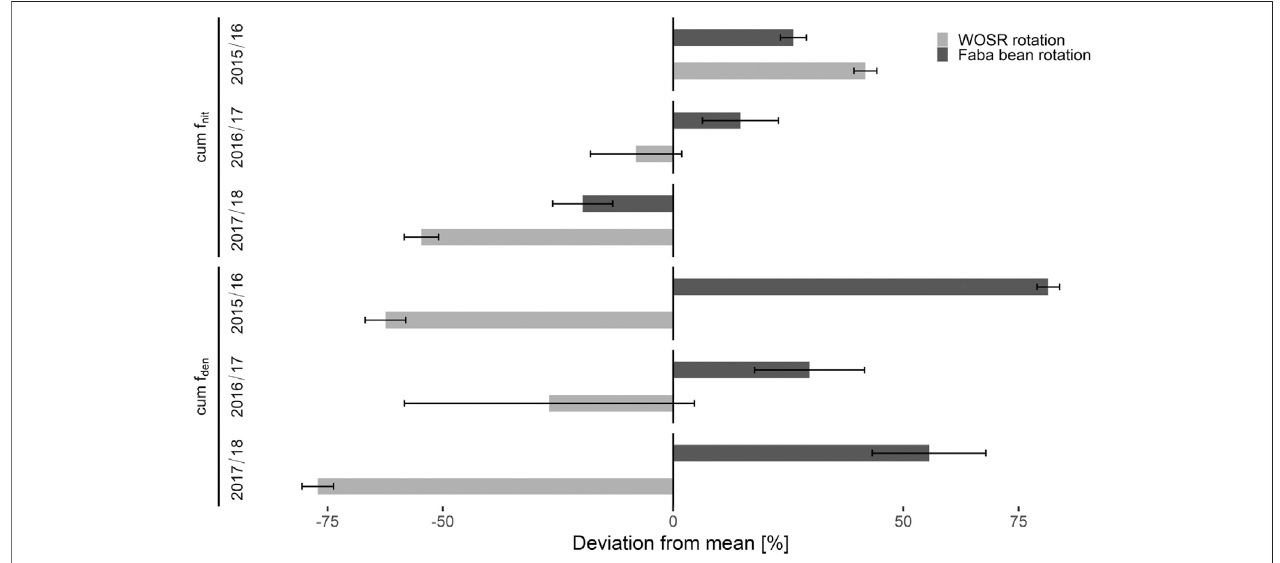
FIGURE 8 | Deviation from the respective mean of the cumulated daily abiotic factors for nitri fi cation and denitri fi cation, averaged per season; error bars indicate ± standard error across replications. High values of the abiotic factors equal conditions favoring N 2 O emissions.